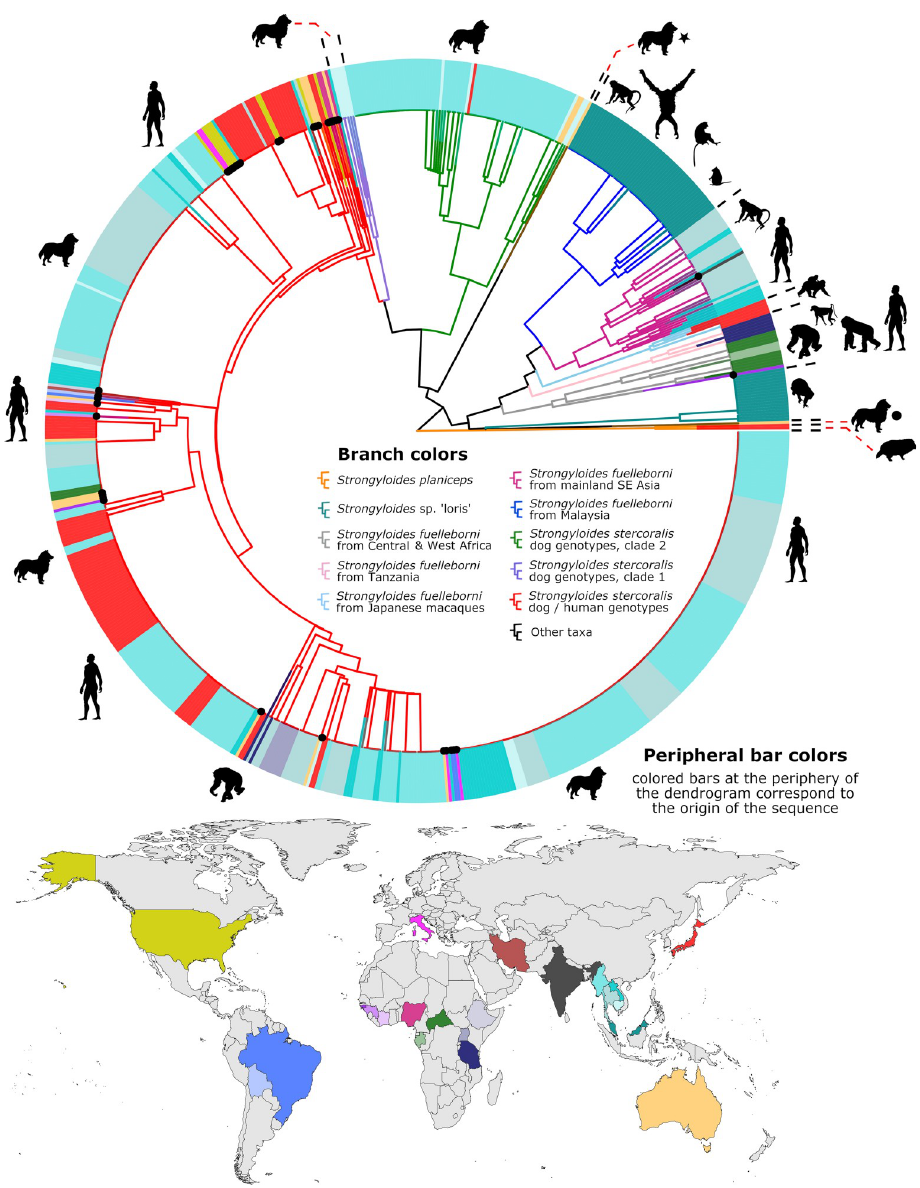
Fig 2. Dendrogram of clustered cox1 sequences. This dendrogram represents 787 cox1 sequences, including those generated by Barratt et al. (branches tipped in a black dot) and all published cox1 sequences from GB (at the time this figure was originally prepared) that overlap completely with our 217 base cox1 amplicon (to our knowledge). Peripheral bars are colored according to their site of origin, which corresponds to the colored countries on the map. Branches are color coded separately, according to their identity; either a species assignment, a genus, or their S . stercoralis genotype. The dog image with a black star indicates a sequence from an Australian dog generated by us previously [21], that is distinct from other Strongyloides spp. and clusters between the S . stercoralis and S . fuelleborni groups. The dog image with a black circle highlights a published sequence [21] that clusters close to, yet is distinct from Strongyloides spp. detected previously in lorises [27]. Animal images reflect the mammalian hosts that the sequences were associated with. Two sequences of Strongyloides planiceps (orange branches) from Japanese raccoon dogs serve as an outgroup. The identity of each sequence is provided in S1 Fig which is a searchable PDF of the same dendrogram with all GB accession numbers, the countries of origin, and host species provided. The GB accession numbers for sequences in this dendrogram that were generated as part of this study (branches tipped in a black dot) are provided in S1 File. The sequences used to construct this dendrogram are provided in S2 File. This figure incorporates all corrections detailed in Table